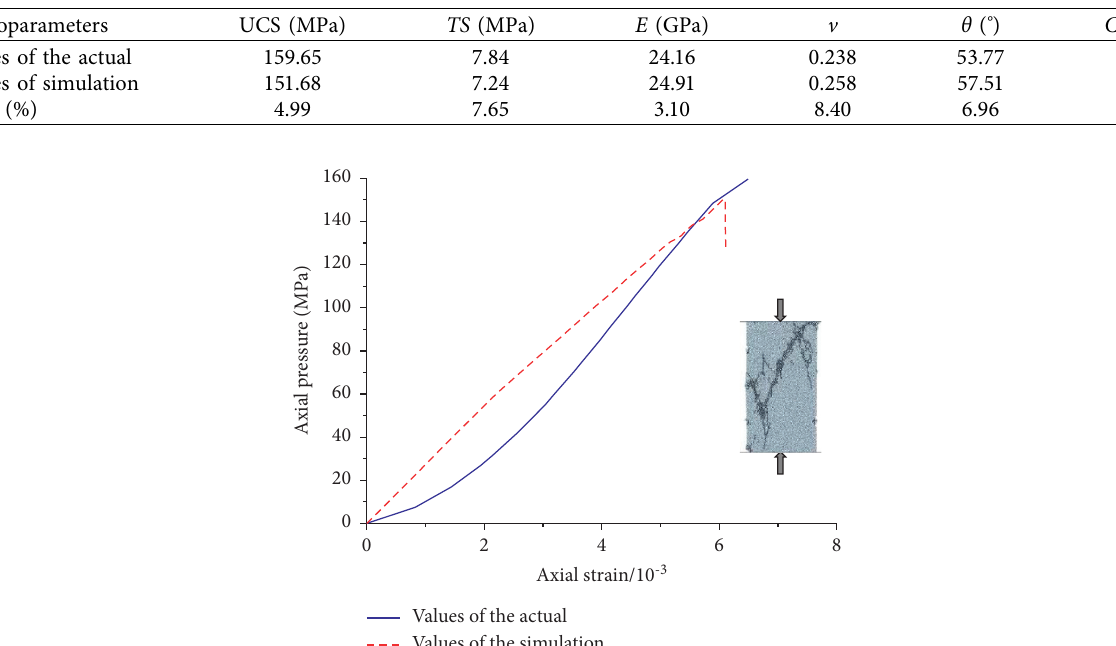
Table 7: Actual and simulated values of the macroparameters of dolomite.